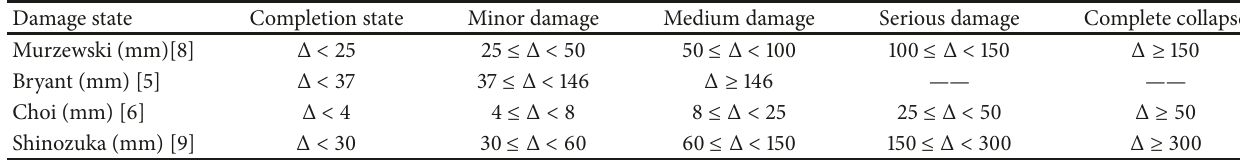
Figure 10: Mechanical properties of stirrup. Table 7: The limit state of bridge platform.